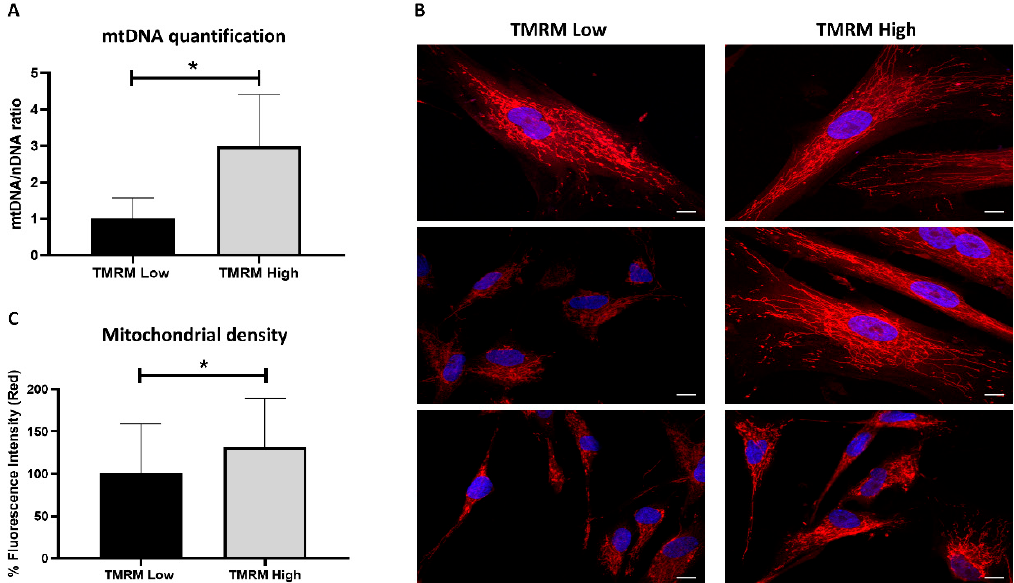
Figure 3. Mitochondrial analysis in TMRM-low and high cells. ( A ) mtDNA content was calculated using quantitative real-time PCR by measuring the ratio of mitochondrially encoded NADH: ubiquinone oxidoreductase core subunit 5 ( ND5 , mitochondrial encoded gene) to β 2-microglobulin ( B2M , nuclear encoded gene) DNA levels. Data are represented as mean ± SD. n = 5 per group. Statistical di ff erences were calculated significant as * p < 0.05, determined by Student’s t -test. ( B ) Representative confocal pictures of MitoTracker Red CMXRos / DAPI to visualize the mitochondrial network. Magnification 63x. Calibration bar 10 µ m. ( C ) Percent red fluorescence intensity of MitoTracker staining was calculated using ImageJ software. Data are represented as mean ± SD. Statistical di ff erences were calculated significant as * p < 0.05, determined by Student’s t -test.